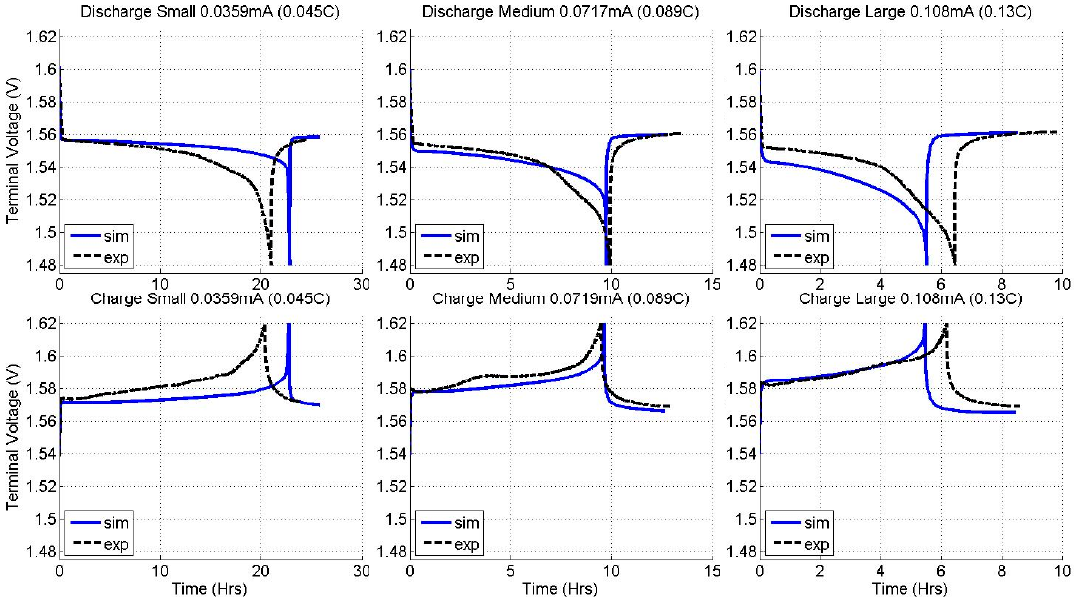
Figure A3. Experimental validation of terminal voltage of LTO half-cell without considering the current dependency of D s .